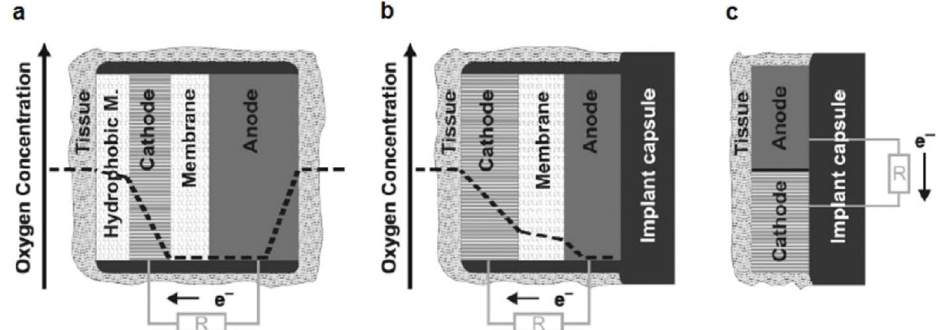
Fig. 2. Abiotic glucose fuel cell designs: (a) “stacked assembly” [1], (b) “depletion design” [12,13]; (c) “single layer design” [15]. The dashed line qualitatively indicates the progression of the oxygen concentration inside the abiotic glucose fuel